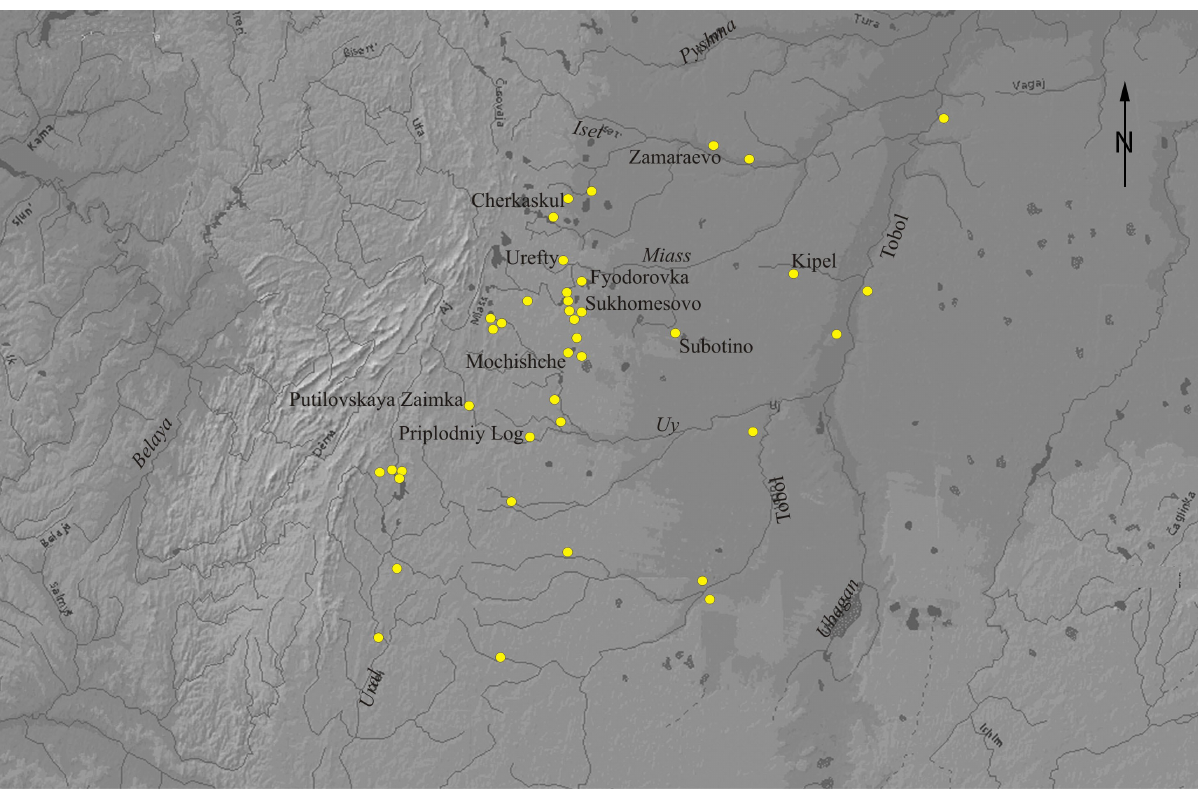
Figure 21: Map of the distribution of Fyodorovka sites in the Transurals. The border between the steppe and forest-steppe is along the Uy River and along the Ural Mountains (after Grigoriev, 2008).